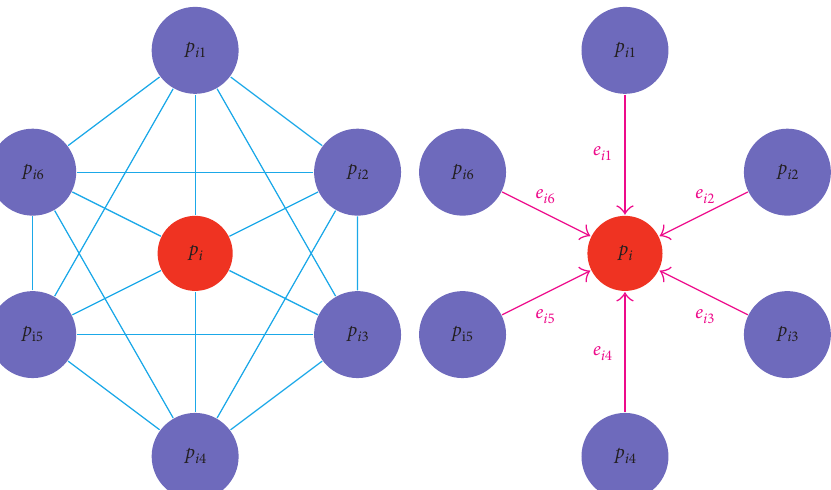
Figure 2: Local graph of point cloud. p from the neighbors to the central point are denoted by e i